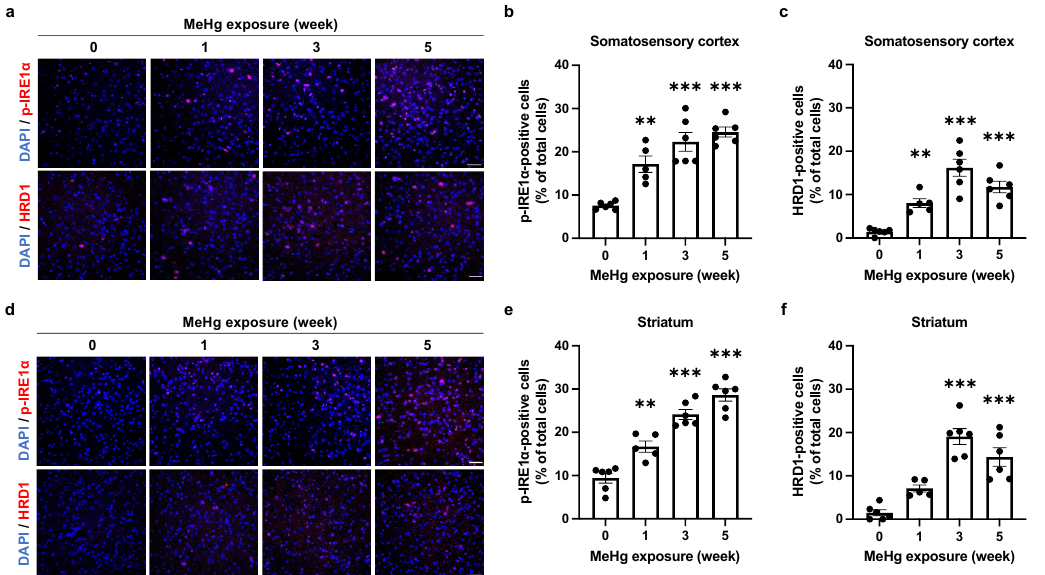
Figure 3. Effect of MeHg exposure on IRE1α -XBP1 axis in the mouse brain. ( a , d ) Detection of p-IRE1 α and HRD1 in the somatosensory cortex ( a ) or striatum ( d ) of ERAI-Venus mice exposed to MeHg for the indicated times. Each scale bar represents 50 μm. ( b , e ) Quantification of p- IRE1α -positive cells in the somatosensory cortex ( b ) or striatum ( e ). ( c , f ) Quantification of HRD1-positive cells in the somatosensory cortex ( c ) or striatum ( f ). Data are expressed as the mean ± S.E.M. values (n = 5 – 6, ** p < 0.01, and *** p < 0.001: significant difference compared with control mice without MeHg exposure (0 weeks) by one- way ANOVA with Dunnett’s post hoc test).